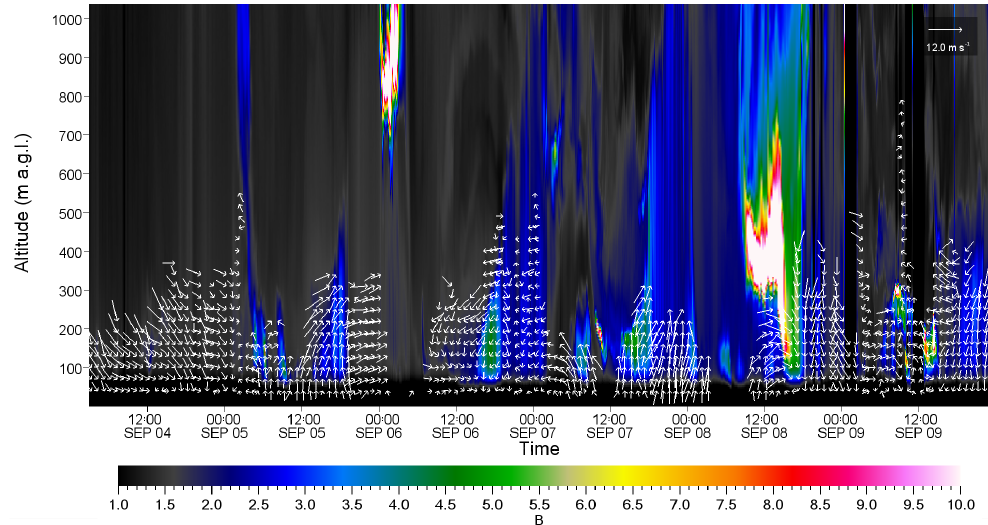
Figure 20. WindRASS data overlaid on 4–9 September AMOLITE aerosol backscatter ratio